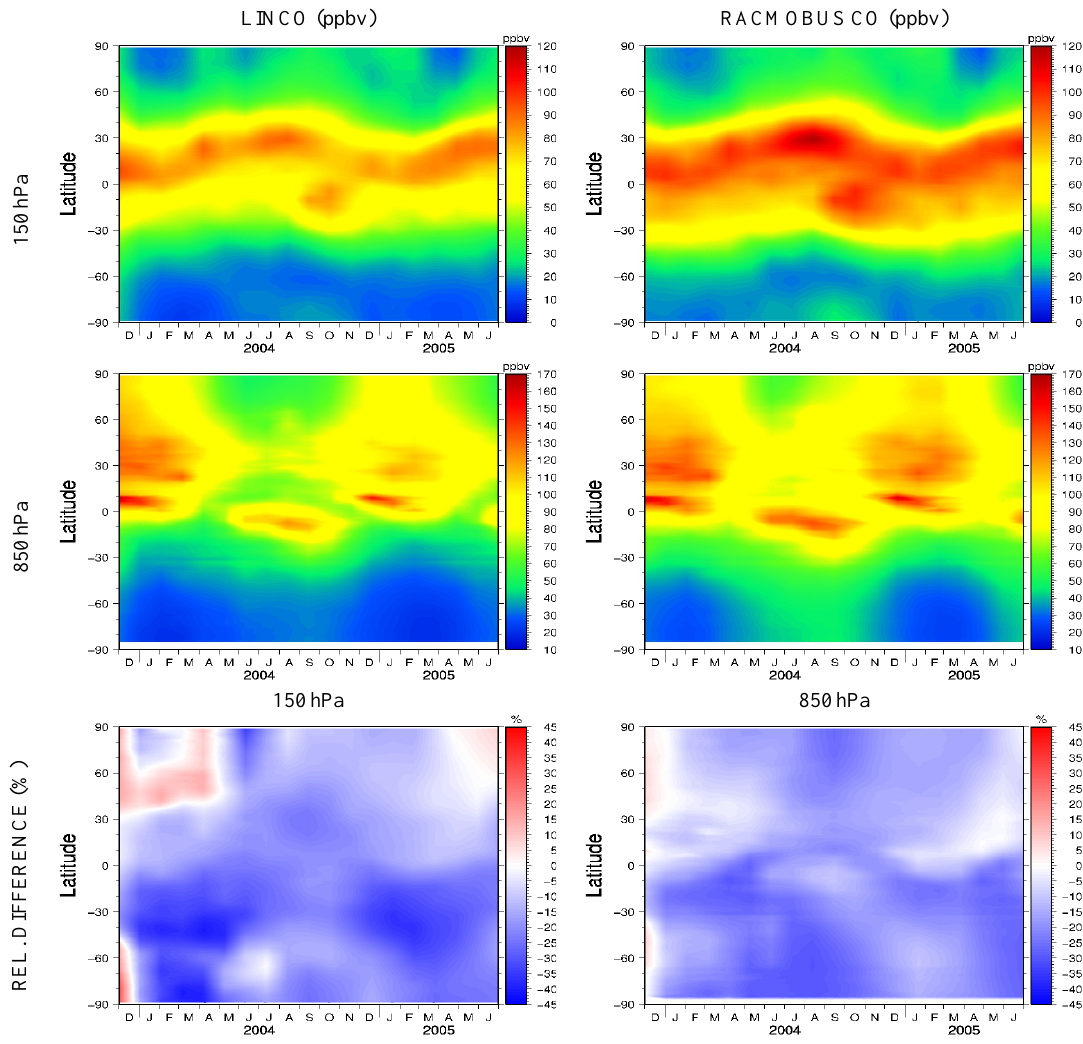
Fig. 2. LINCO (left) and RACMOBUS (right) zonal mean of CO in parts per billion by volume (ppbv) from December 2003 to June 2005 at 150hPa (top) and 850hPa (middle). Corresponding relative differences (LINCO-RACMOBUS)/RACMOBUS x100 in % are plotted at bottom at 150hPa (left) and 850hPa